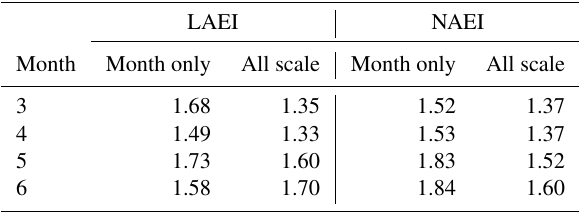
Table 3. Ratio of measured to simulated NO x emissions from both the NAEI and the LAEI. For each inventory the cases for both all scaling factors and only monthly scaling factors are